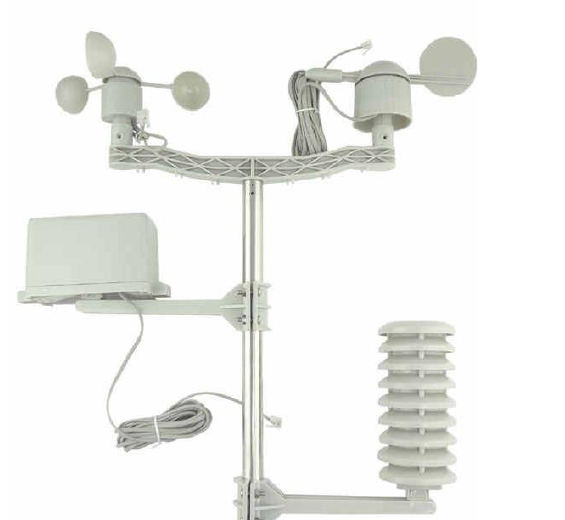
Figure 6. Sensors for indoor air quality: ( a ) air quality, ( b ) gas sensor and ( c ) VOC.